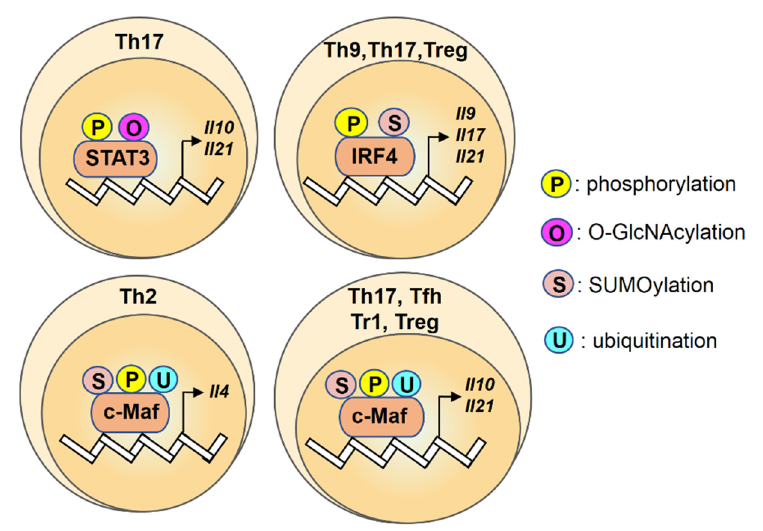
Figure 2. An overview of regulation for transcription factors STAT3, IRF4, c-Maf by post-translational modifications in T helper cells. Transcription factors STAT3, IRF4, c-Maf are regulated by the post-translational modifications (P: phosphorylation; O: O-GlcNAcylation; S: SUMOylation; U: ubiquitination) and the color differences indicate various modifications on their targets.